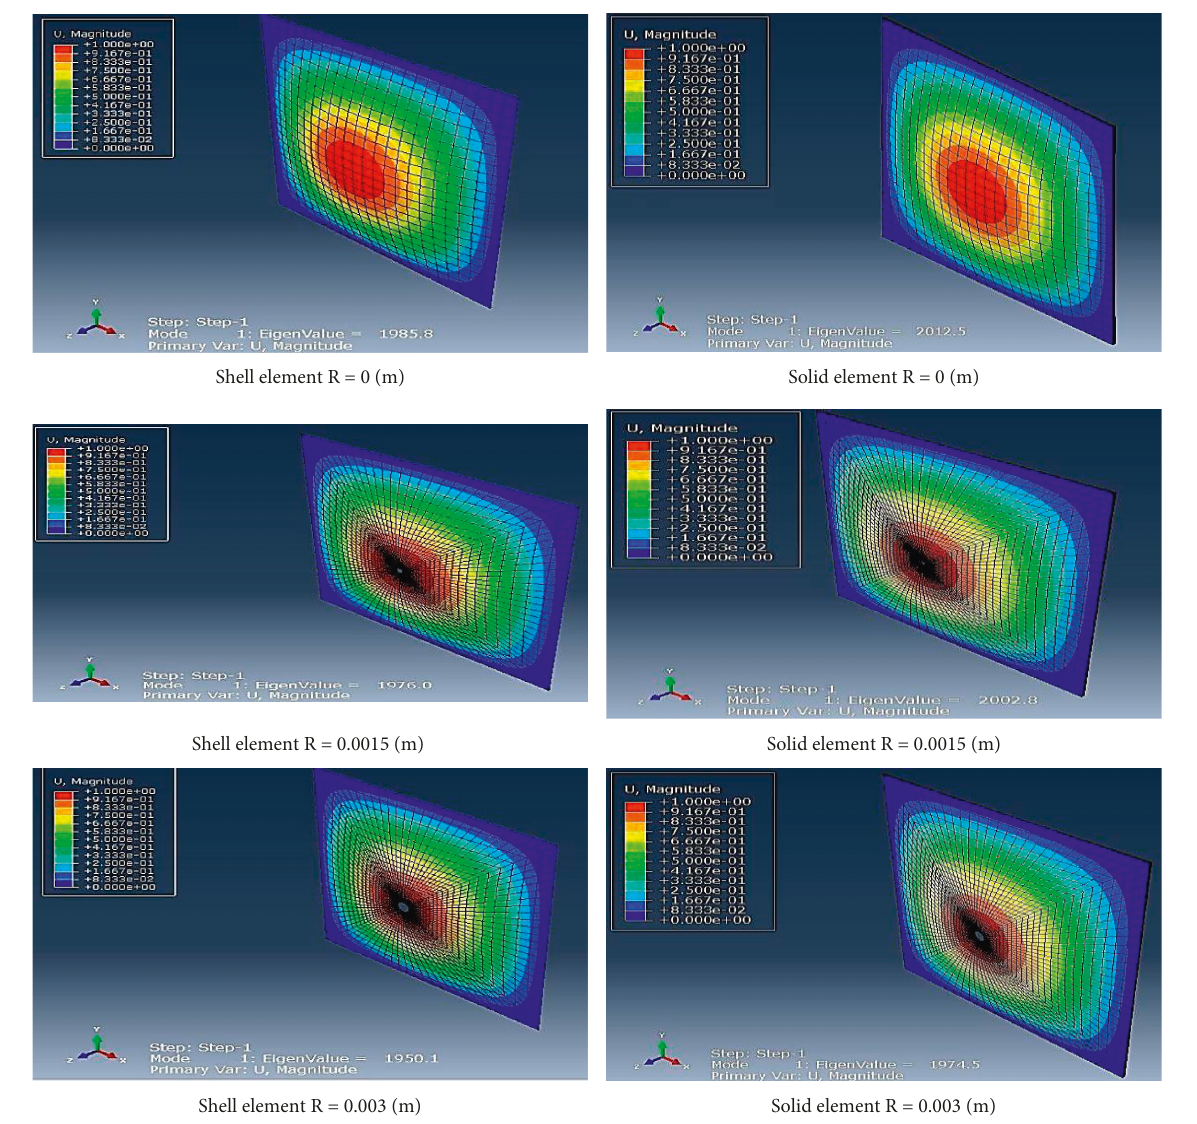
Figure 6: Plate tension with different cavity radii. Table 7: Specifications of presented